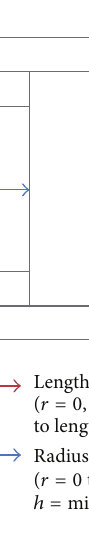
Figure 5: Semimajor and semiminor axis.